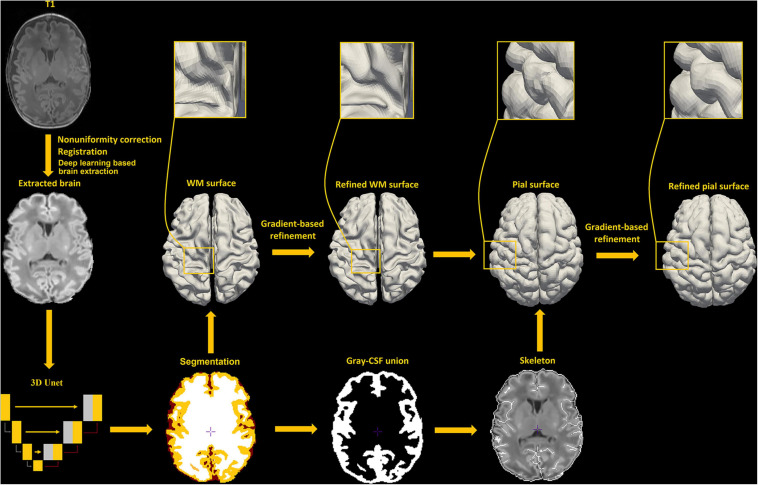
An illustration of pial surface reconstruction pipeline steps in this study.